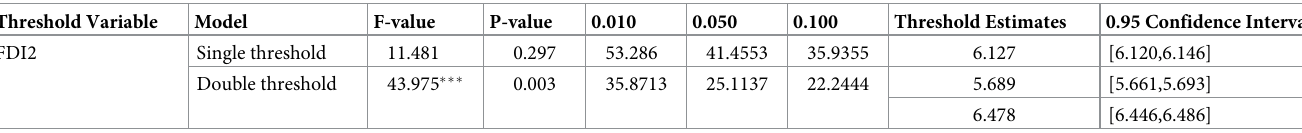
Table 4. FDI quality threshold significance test and confidence